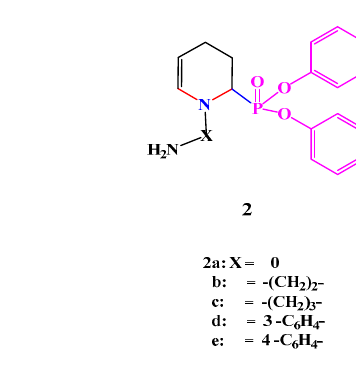
Figure 1. Structures of cyclic diphenylphosphonates 1 and 2 .